Question: Condense the content of this figure into a single sentence.
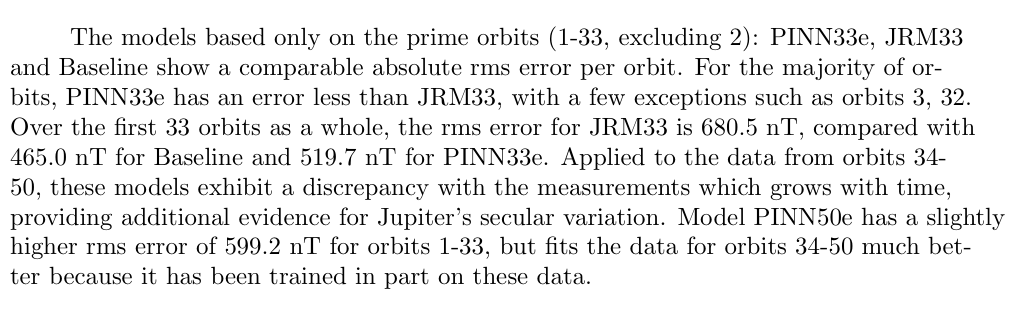
Answer: shows the physics-loss by contours of the magnitude of electrical current density |J| on selected radii. For radii r > RJ, the magnitude of the current density of the PINN50e model is about 10−8A/m2, increasing with decreasing radius to about 10−6A/m2 at r = 0.8RJ. The current density includes a signature from not only any external electrical currents, but also electro-magnetic structures which are numerically favoured because they allow a good fit to the data. Estimates of the current density as- sociated with a simple magnetodisk model are about 10−9A/m2 at r = 5RJ (Conner- ney, 1981), which is consistent with our values in r > RJ. The increase of |J| by 100 from r = 4 to r = 0.8 is principally explained by the increase in magnetic field strength by a similar factor due to proximity to the dynamo source. Structurally, at large radii, |J| appears dominated by weak small-scale numerical artefacts; however, as the radius decreases, |J| becomes dominated by gradients in B, focus